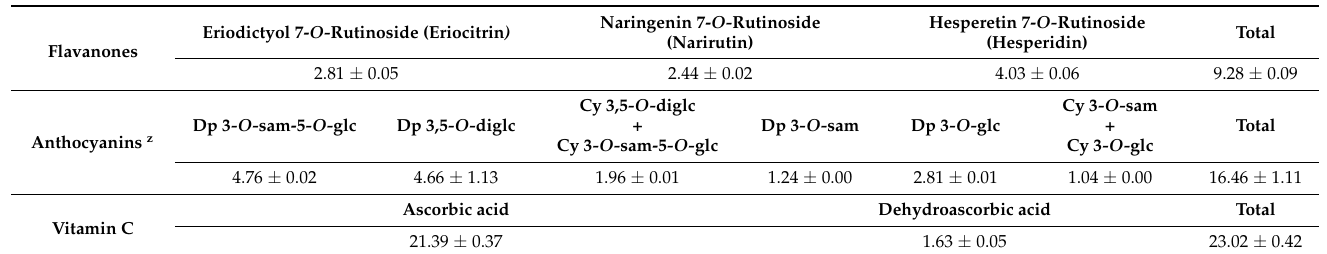
Table 2. Initial concentration (mg/100 mL) of bioactive compounds in the control solutions and maqui–citrus base drink.